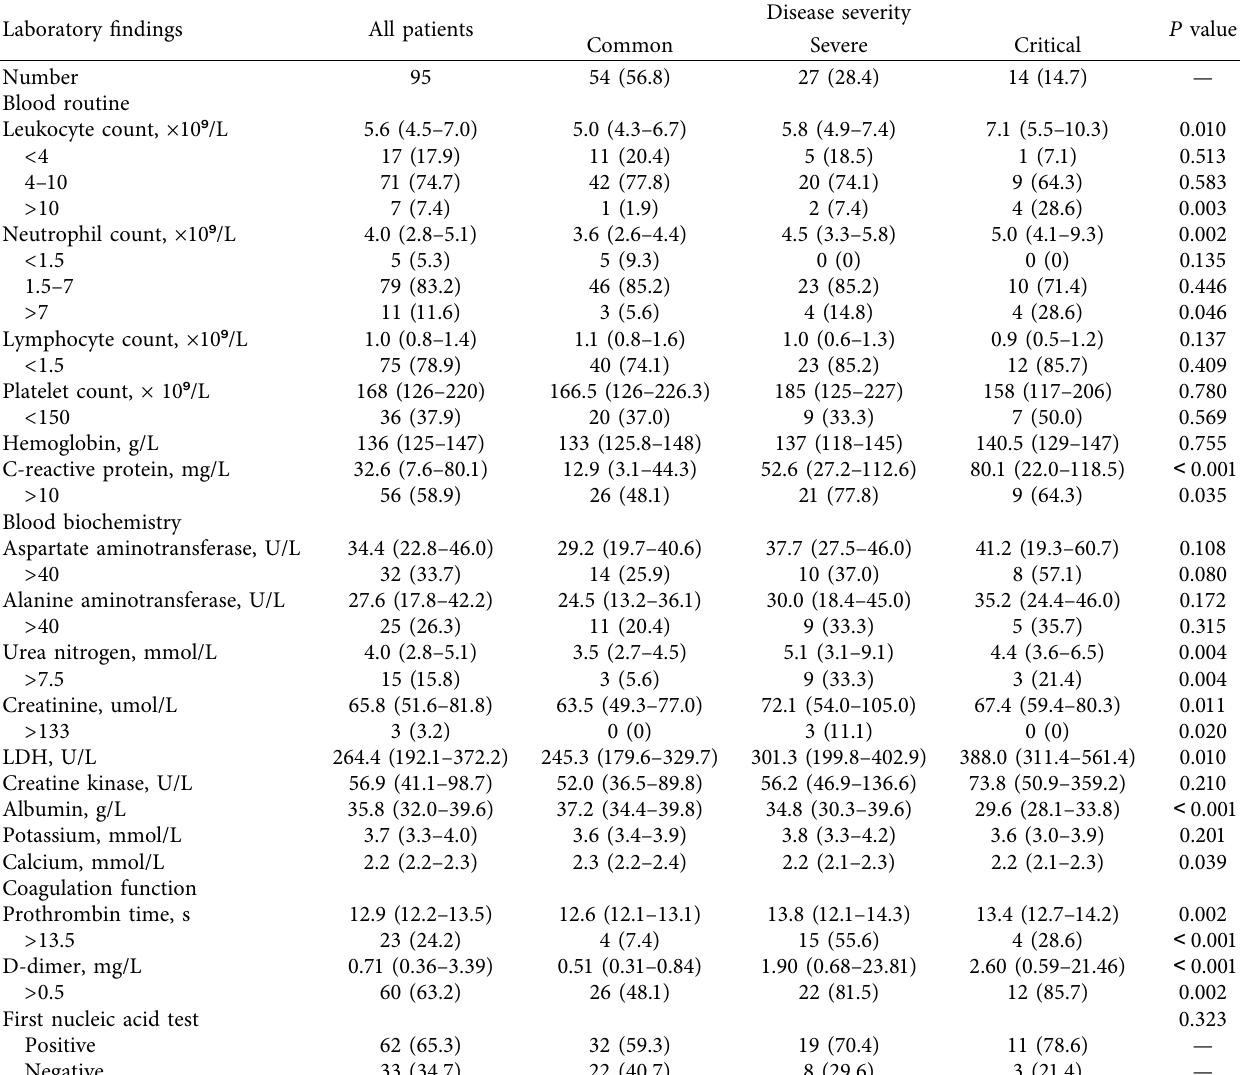
Table 2: Laboratory findings of COVID-19 patients on hospital